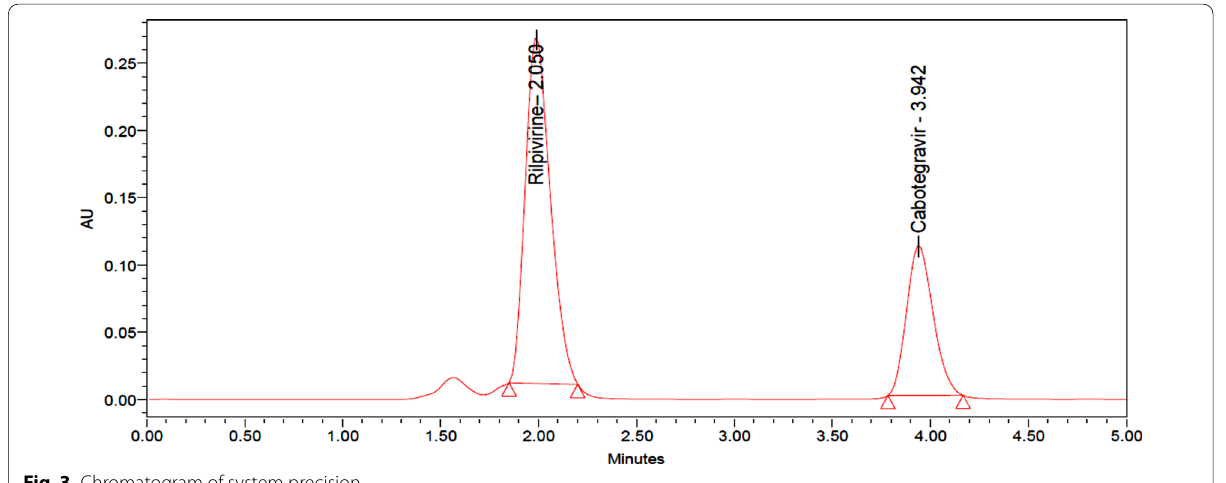
Fig. 3 Chromatogram of system precision